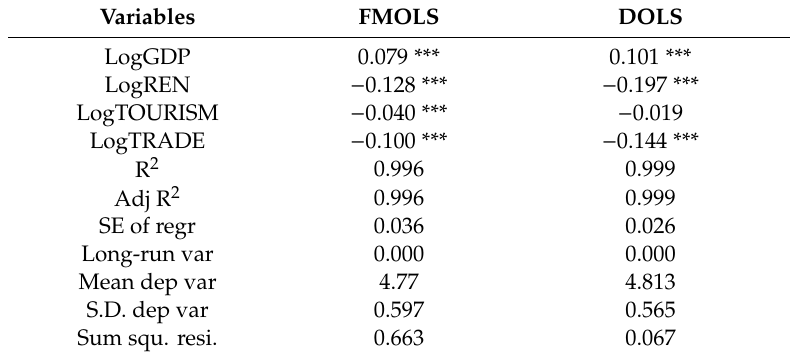
Table 6. Panel Fully Modified Least Squares (FMOLS) and Panel Dynamic Least Squares